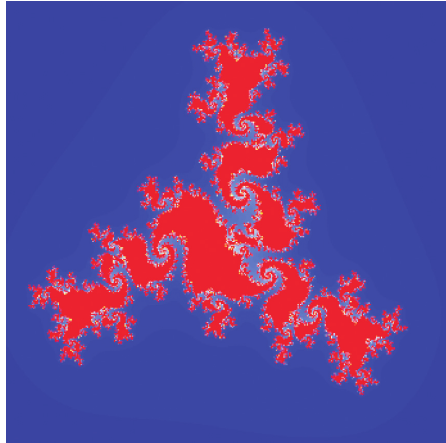
Figure 12: Cubic Julia set in JSOmhh.